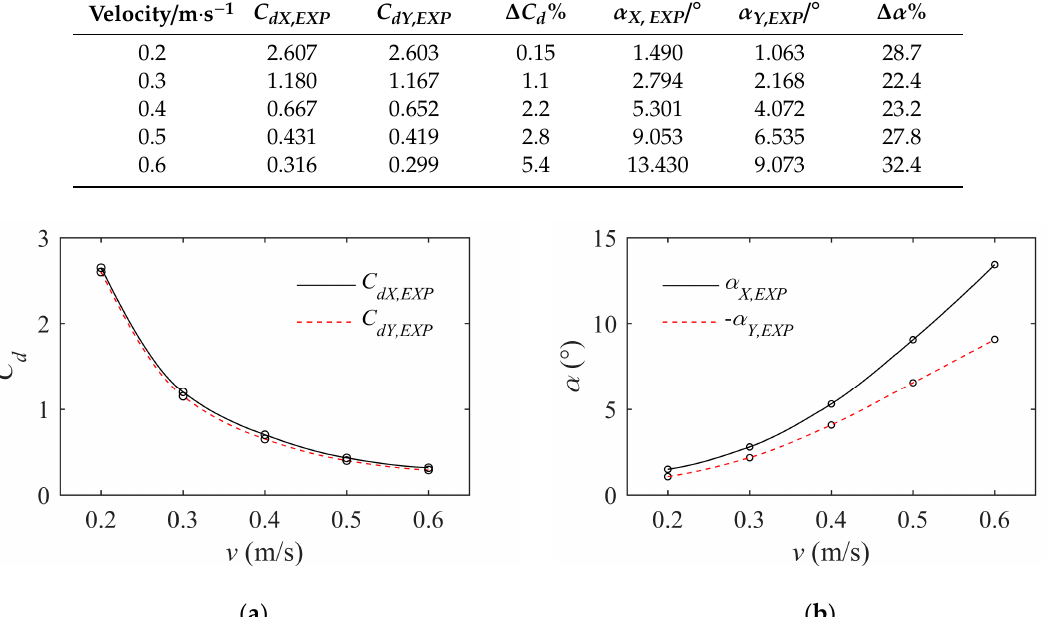
Figure 6. Comparison of average drag coefficients and offset angles: ( a ) Drag force coefficient variation for X and Y-direction towing, ( b ) Offset angle variation for X and Y-direction towing.